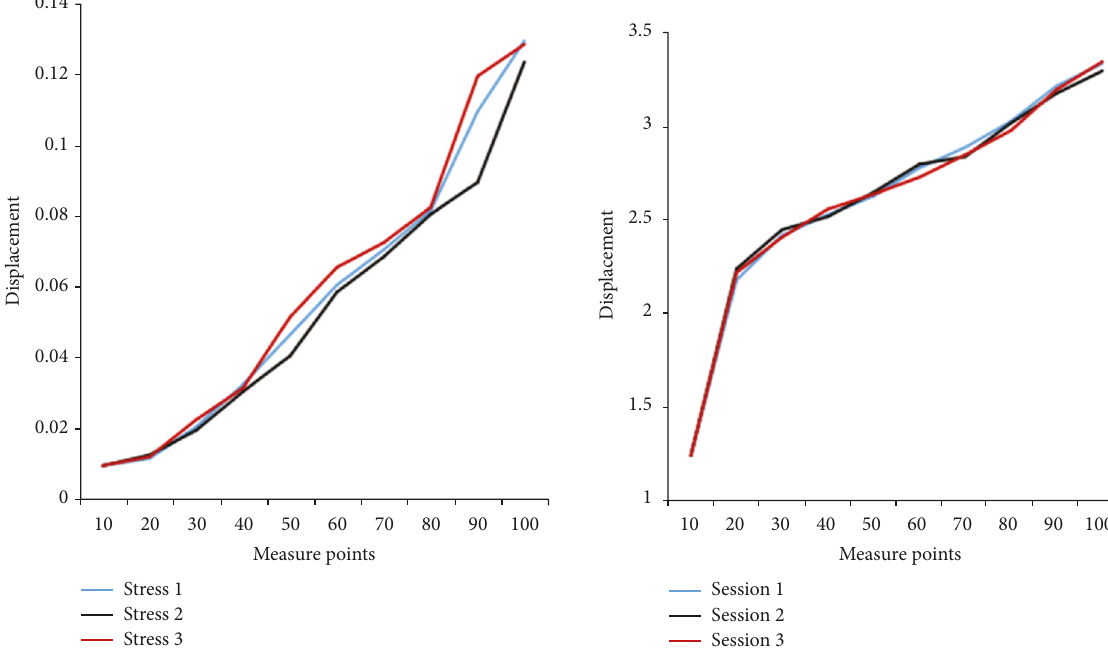
Figure 7: Force measurement point and